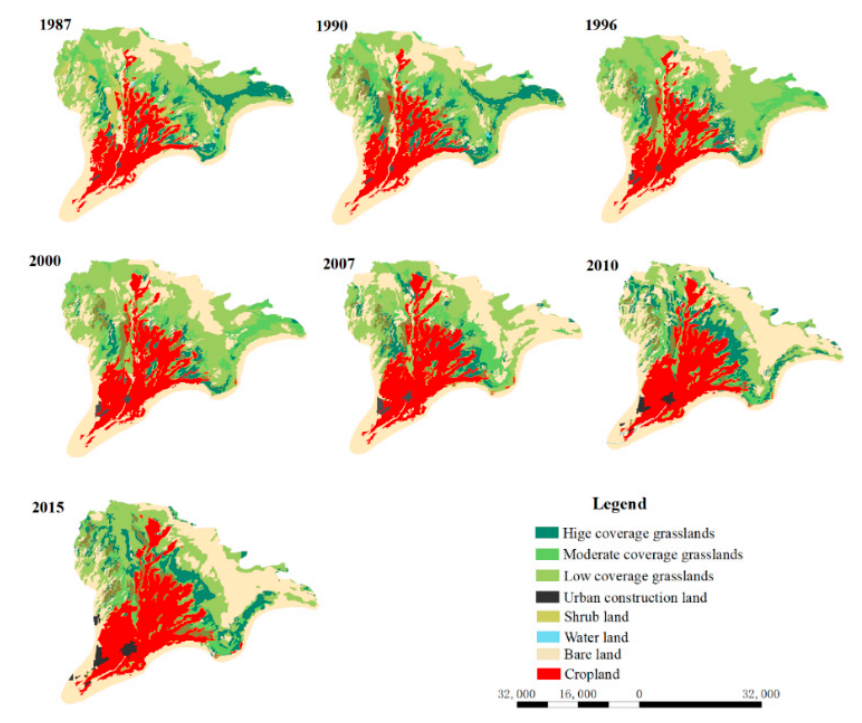
Figure 3. Land use/land cover spatial pattern from 1987 to 2015 in the Dunhuang Oasis.